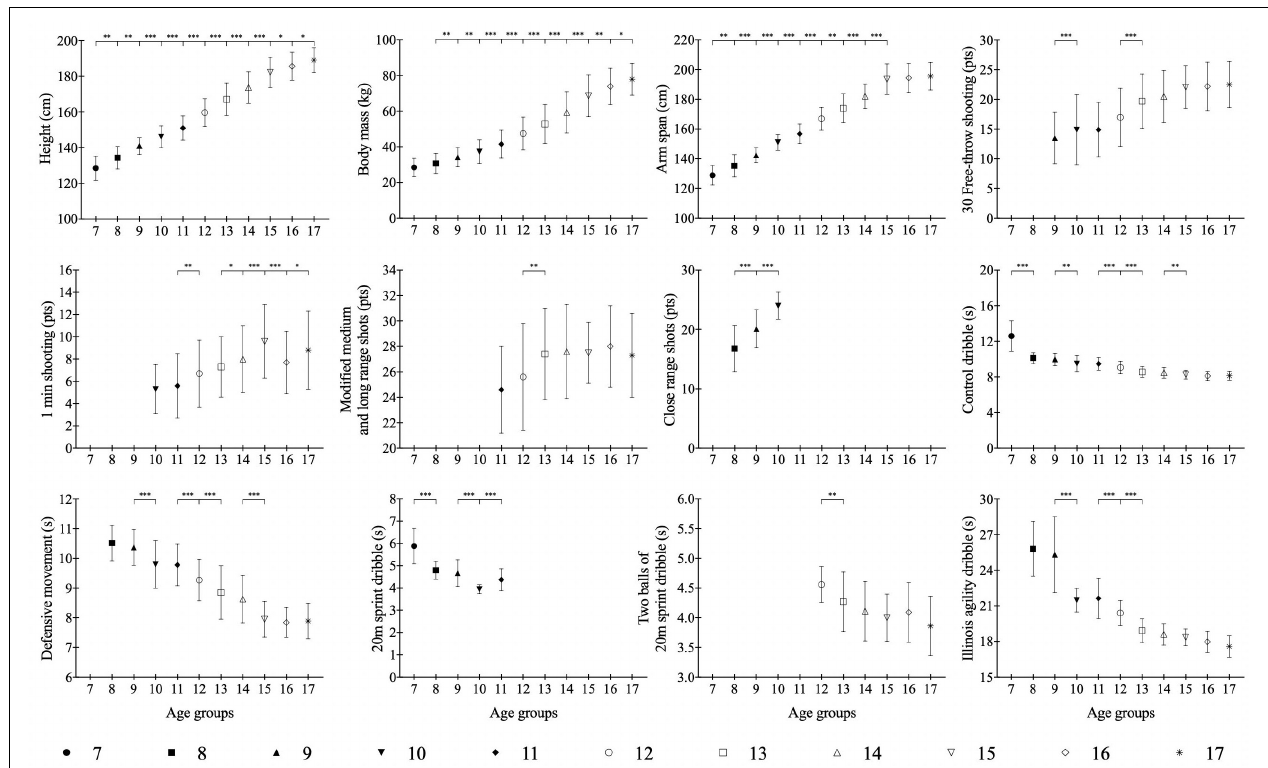
FIGURE 2 | Descriptive characteristics of Lithuanian basketball players aged 7–17 years. ∗ P < 0.05; ∗∗ P < 0.01; ∗∗∗ P <